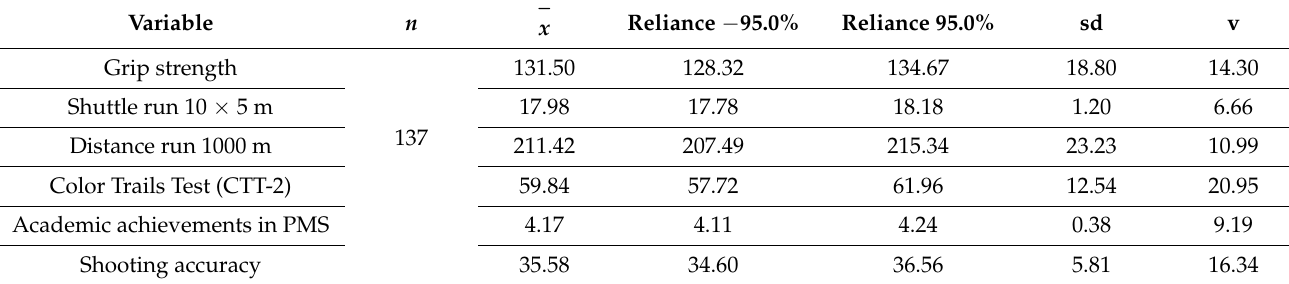
Table 1. Descriptive statistics of the study variables.